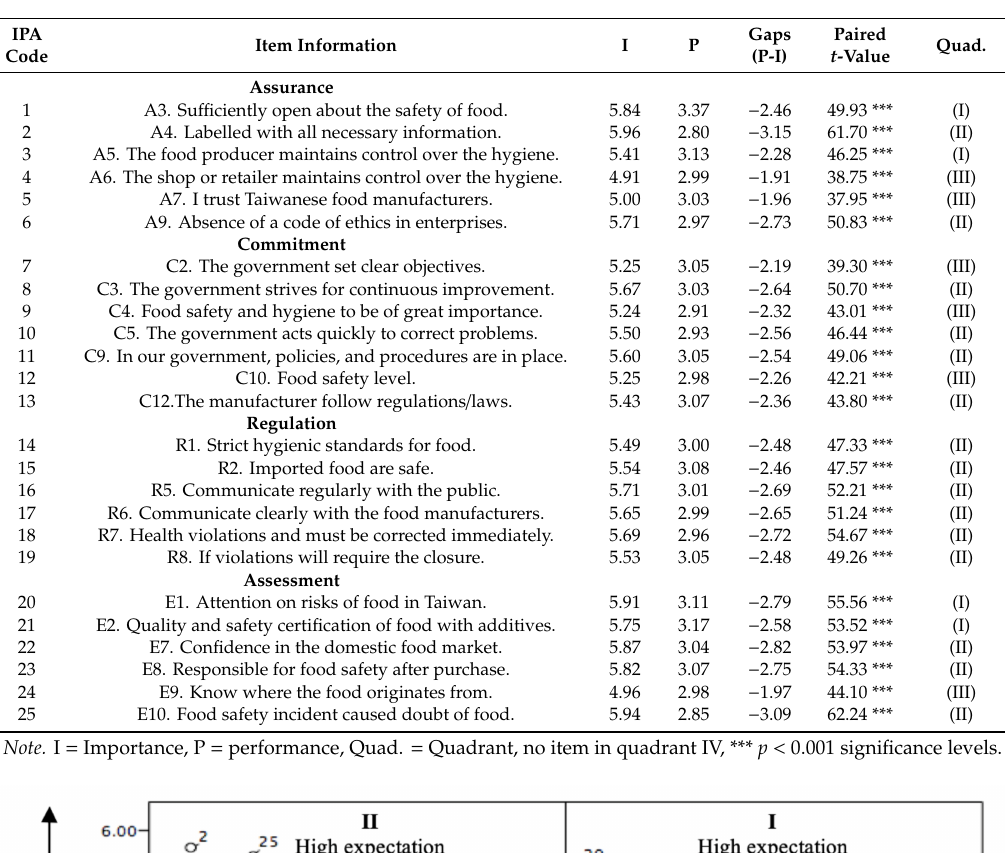
Table 8. Result of IPA.